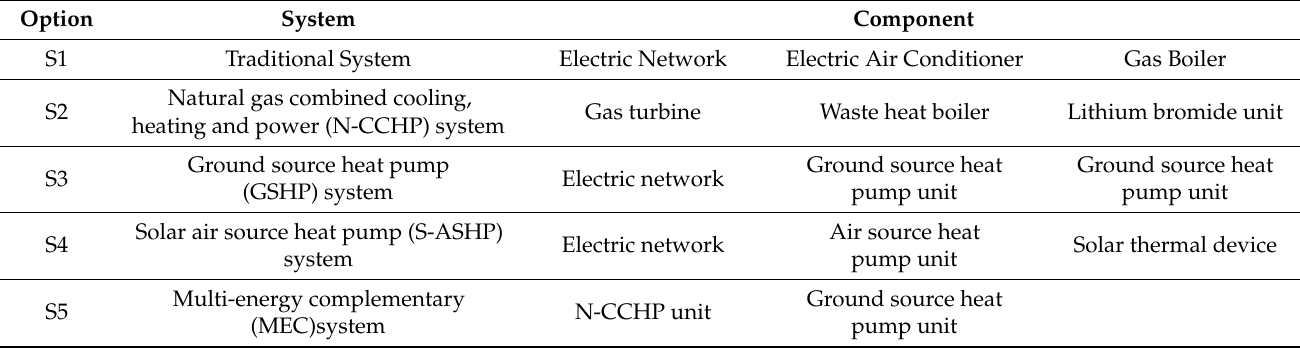
Table 2. Energy system composition.